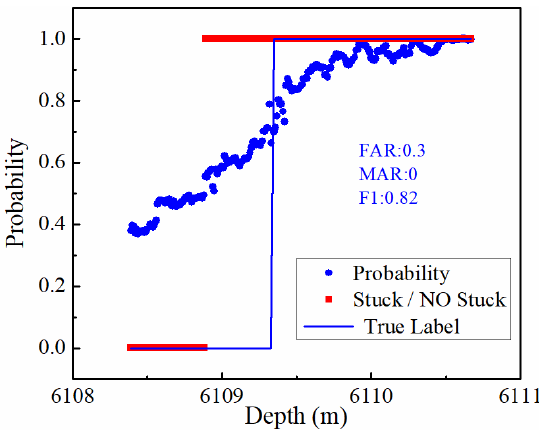
Figure 11. Intelligent prediction of stuck pipe probability.